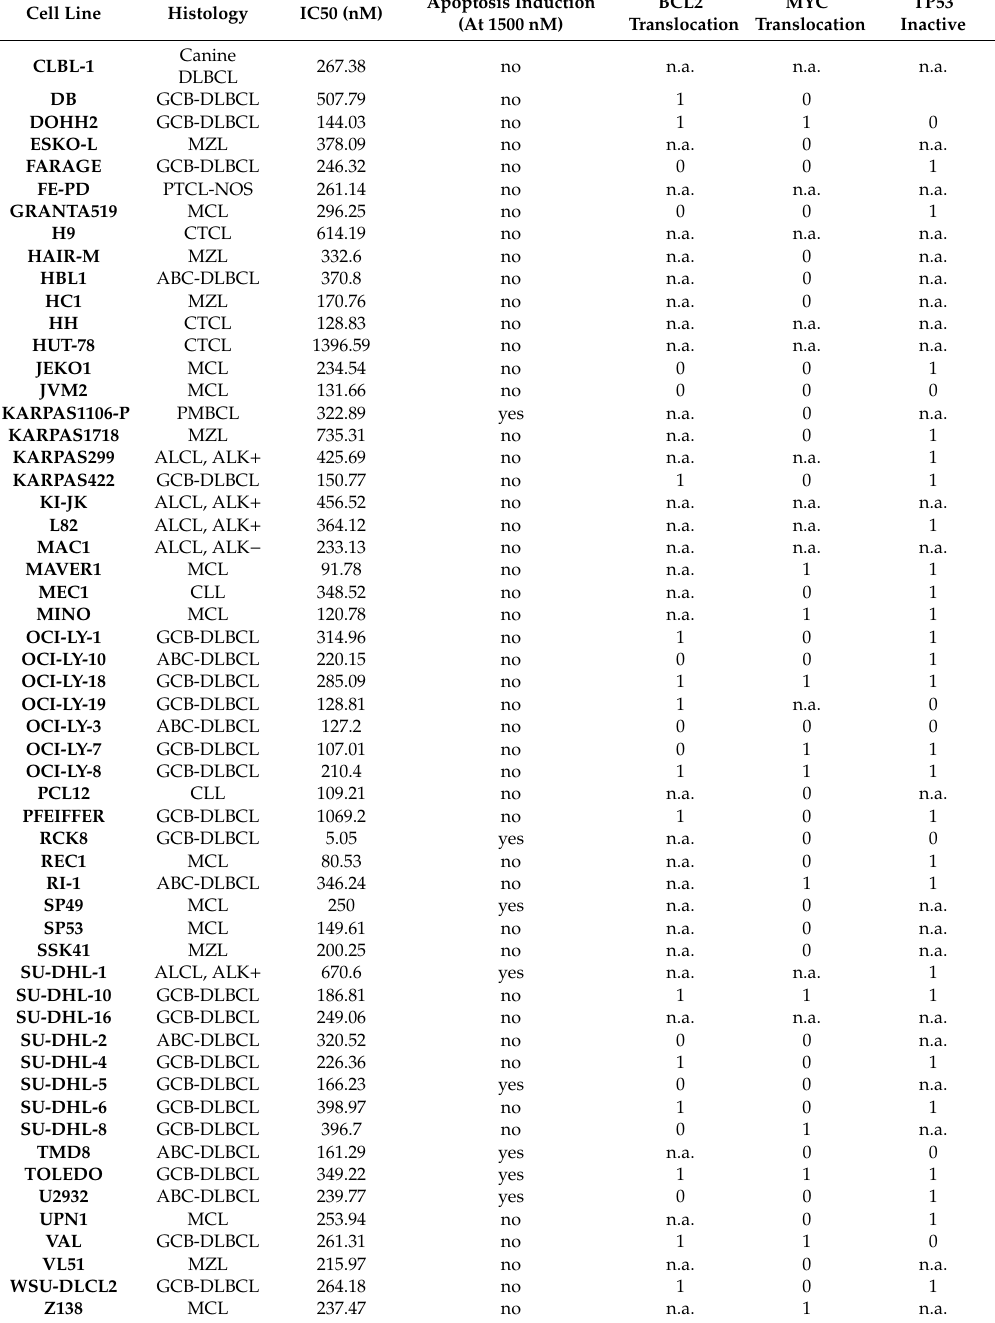
Table 1. Anti-tumor activity of PQR620 in lymphoma cell lines. The IC 50 was calculated after 72 h of drug exposure. Apoptosis was defined by at least a 1.5-fold increase in signal activation with respect to controls. BCL2 , MYC and TP53 status were defined as previously reported